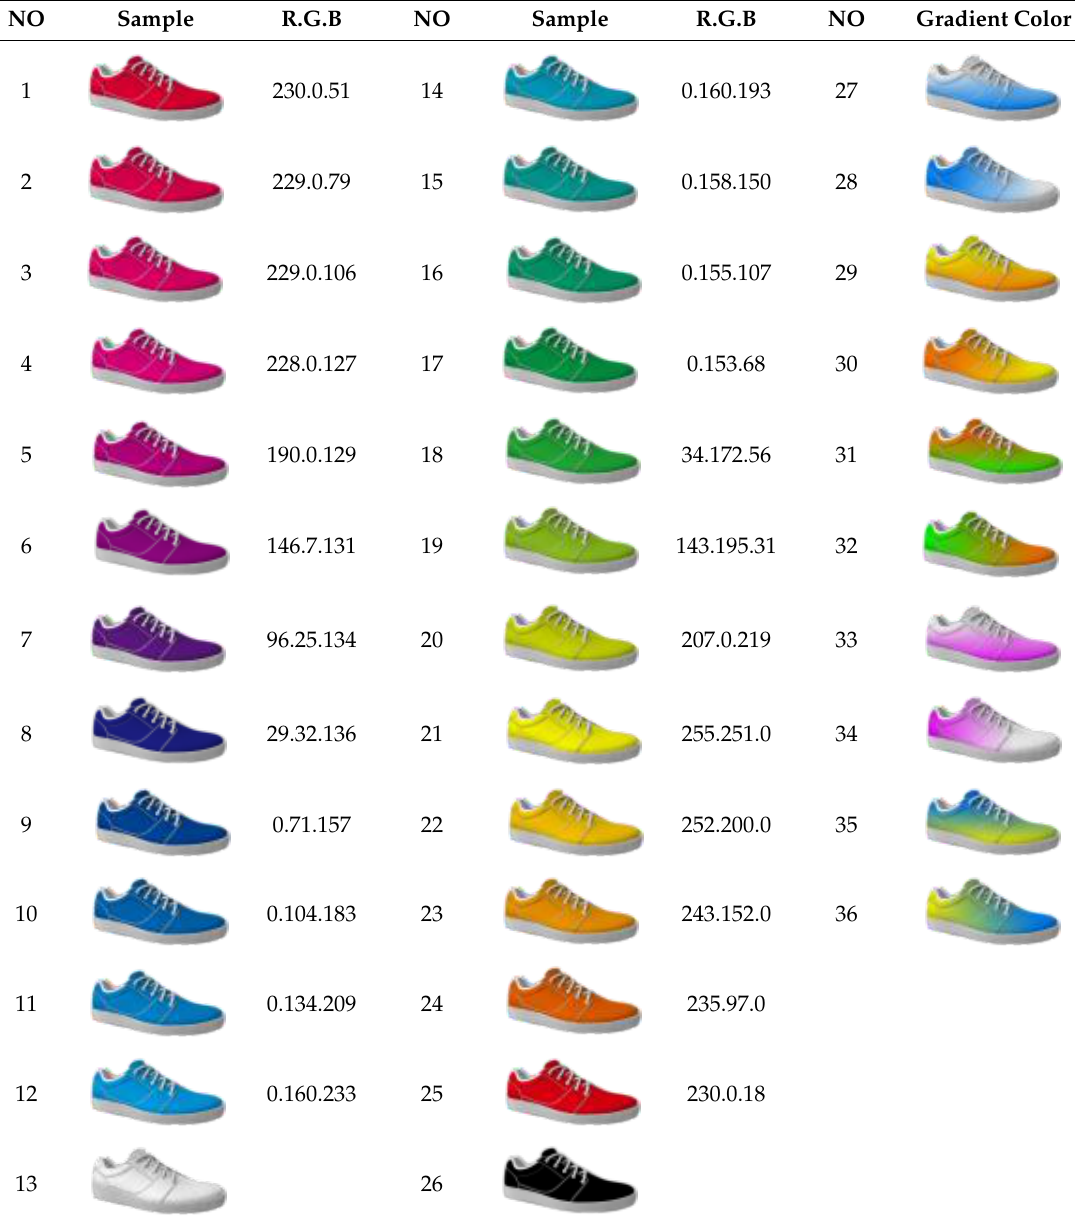
Table 3. The 36 experimental color scheme designs.